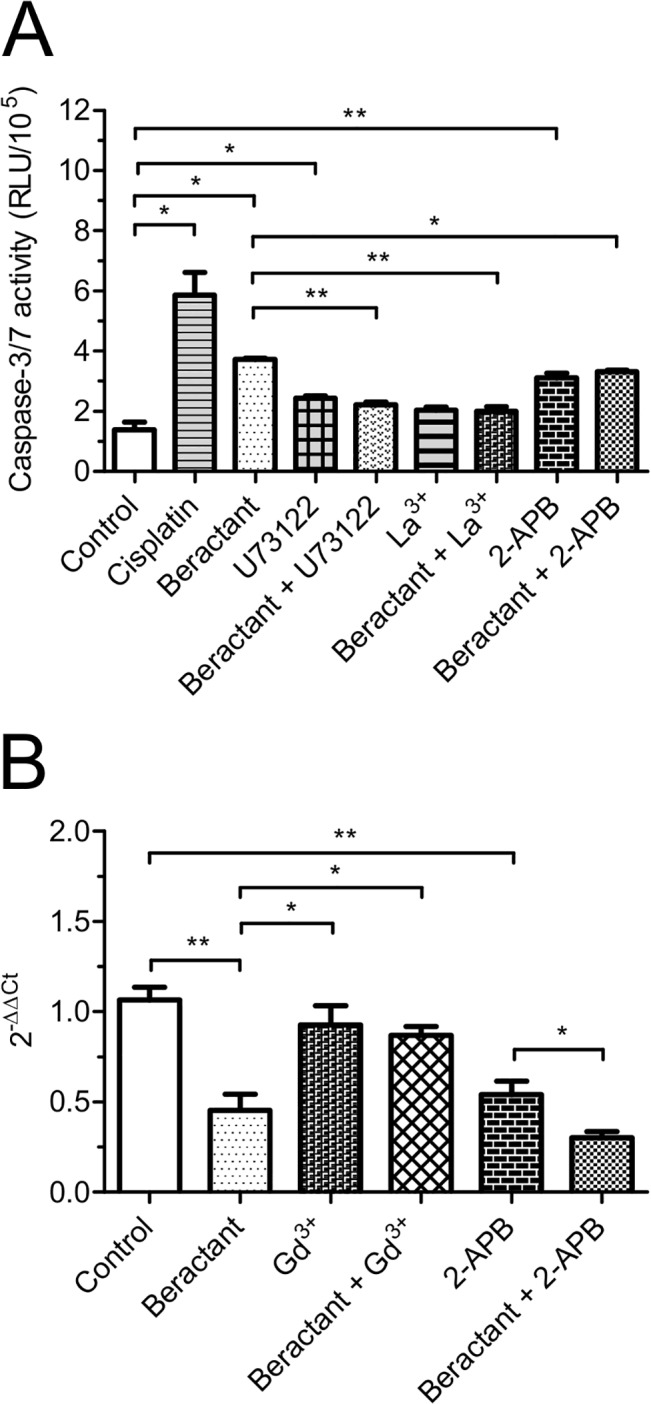
Effect of SOCE inhibitors on Beractant effect in apoptosis and collagen expression.NHLF were incubated for 24 hours with either SOCE inhibitors alone (U73122, 10μM; La3+, 10μM; Gd3+, 10μM or 2-APB, 50 μM) or in combination with beractant 500 μg/ml in serum-free medium. A) Caspase 3 and 7 activity, the Caspase-Glo assay kit (Promega, Madison, WI) was used to measure the executioner caspases 3 and 7. Cisplatin 20 μM was used as positive control. Despite the fact that U73122 and 2-APB exerted a modest, albeit significant, pro-apoptotic effect, they blocked beractant-induced apoptosis. B) Collagen expression. RT-qPCR was used to measure the expression of collagen. All real time PCRs were performed in triplicate at least two times. Results were normalized to human GAPDH using the delta-delta Ct method (2-ΔΔCt). Results are expressed as means ± SE. ANOVA was used with a priory comparisons of selected pairs.